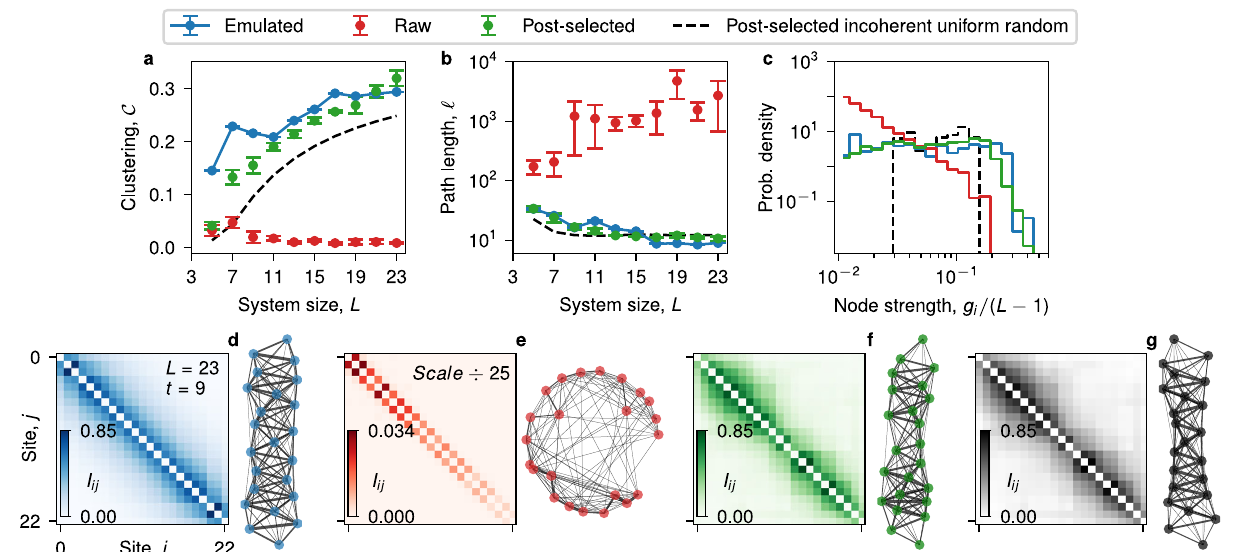
Fig. 4 | Small-world mutual information network behavior. a Coherence win- dow, cycle-and-chain-averaged clustering, C , as a function of system size, L . b Coherence window, cycle-and-chain-averaged path length, ℓ , as a function of systemsize, L . c Normalizednodestrength distribution, P [ g i /( L − 1)], amalgamated over all system sizes. d – g Heatmap and force-directed 41 complex network